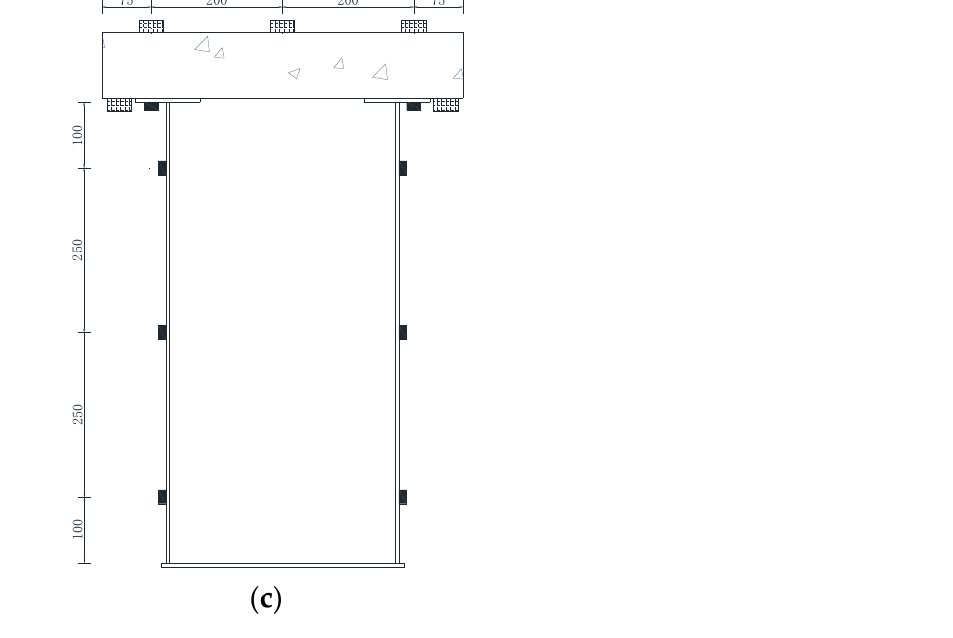
Figure 6. Layout of Dial Gauge (unit: mm).